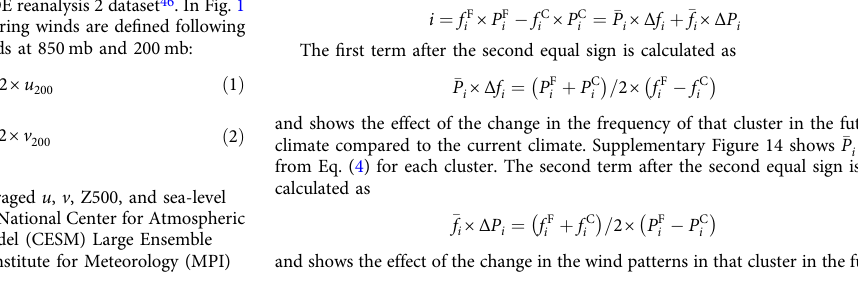
Table 1. We use the historical and RCP8.5 simulations of each model. To compute the multi-model-mean, we fi rst interpolate data from all models to the highest horizontal resolution (0.75°×0.75°), and then calculate the average over all